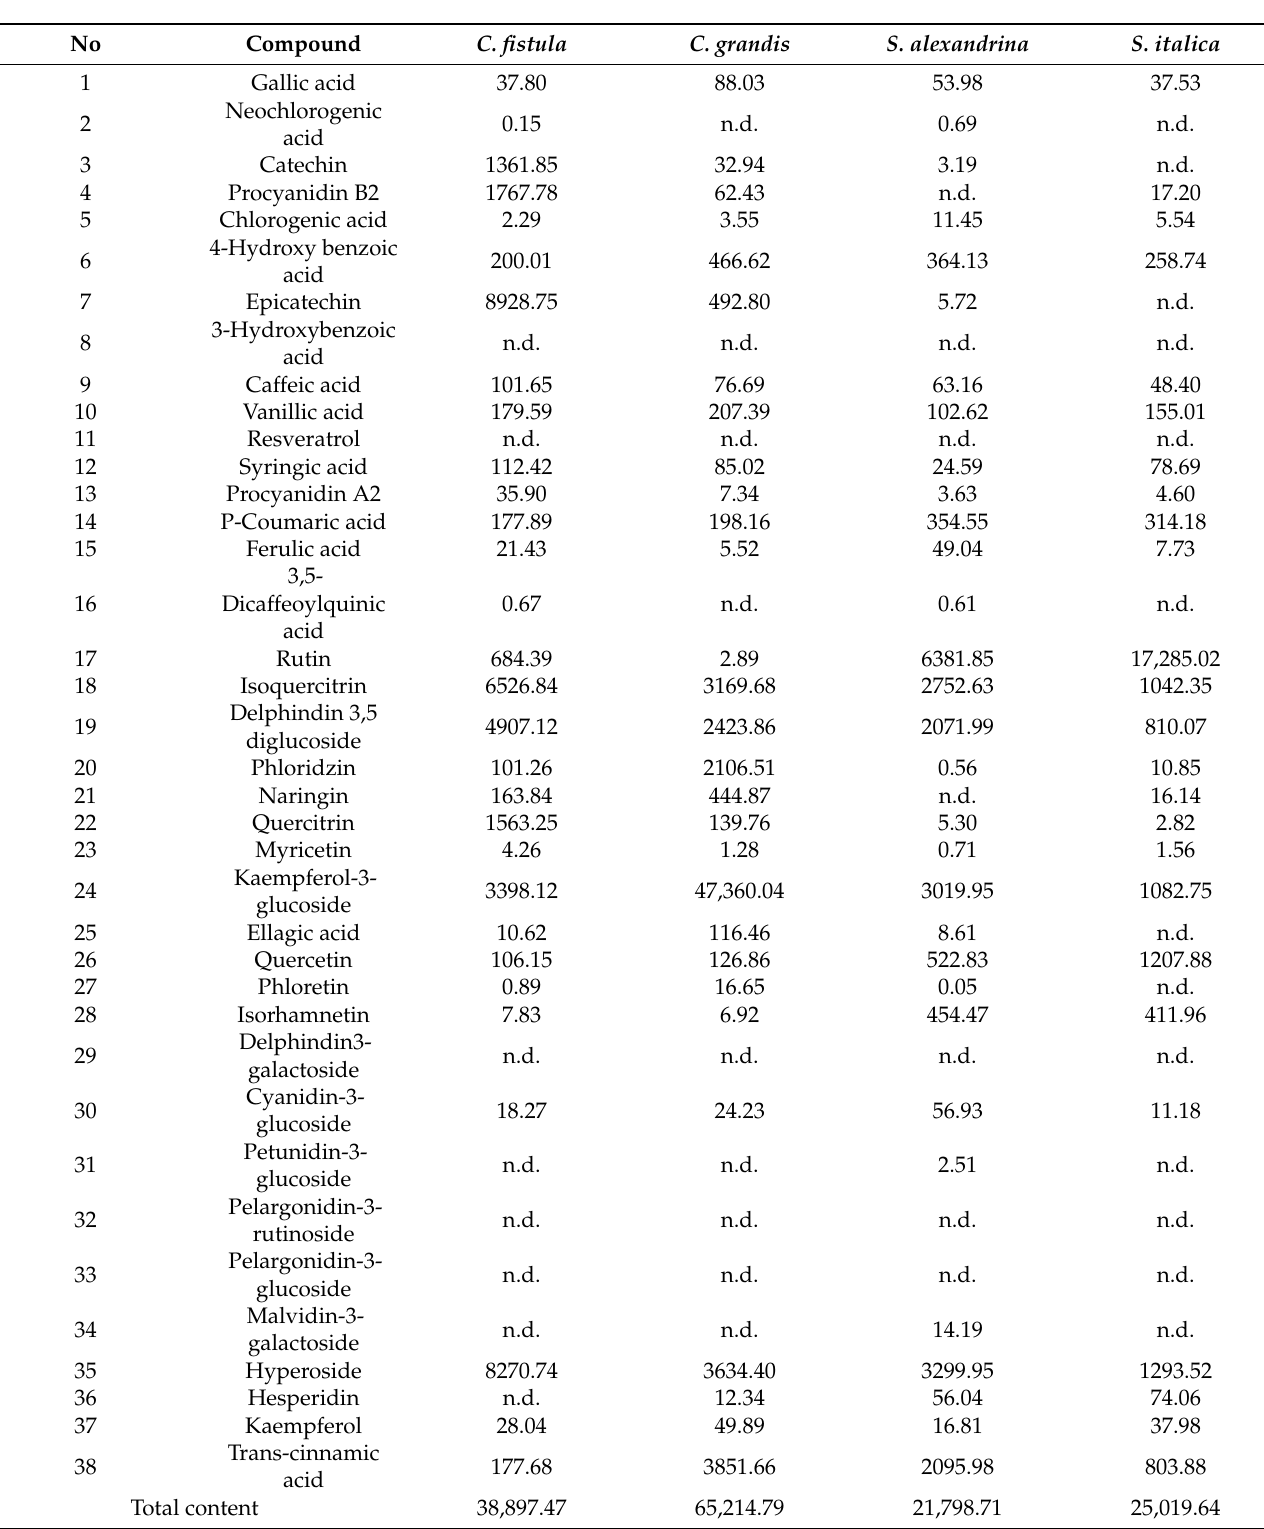
Table 2. Content ( µ g g − 1 of dried extract) of bioactive compounds in leaf methanolic extracts of the Cassia and Senna